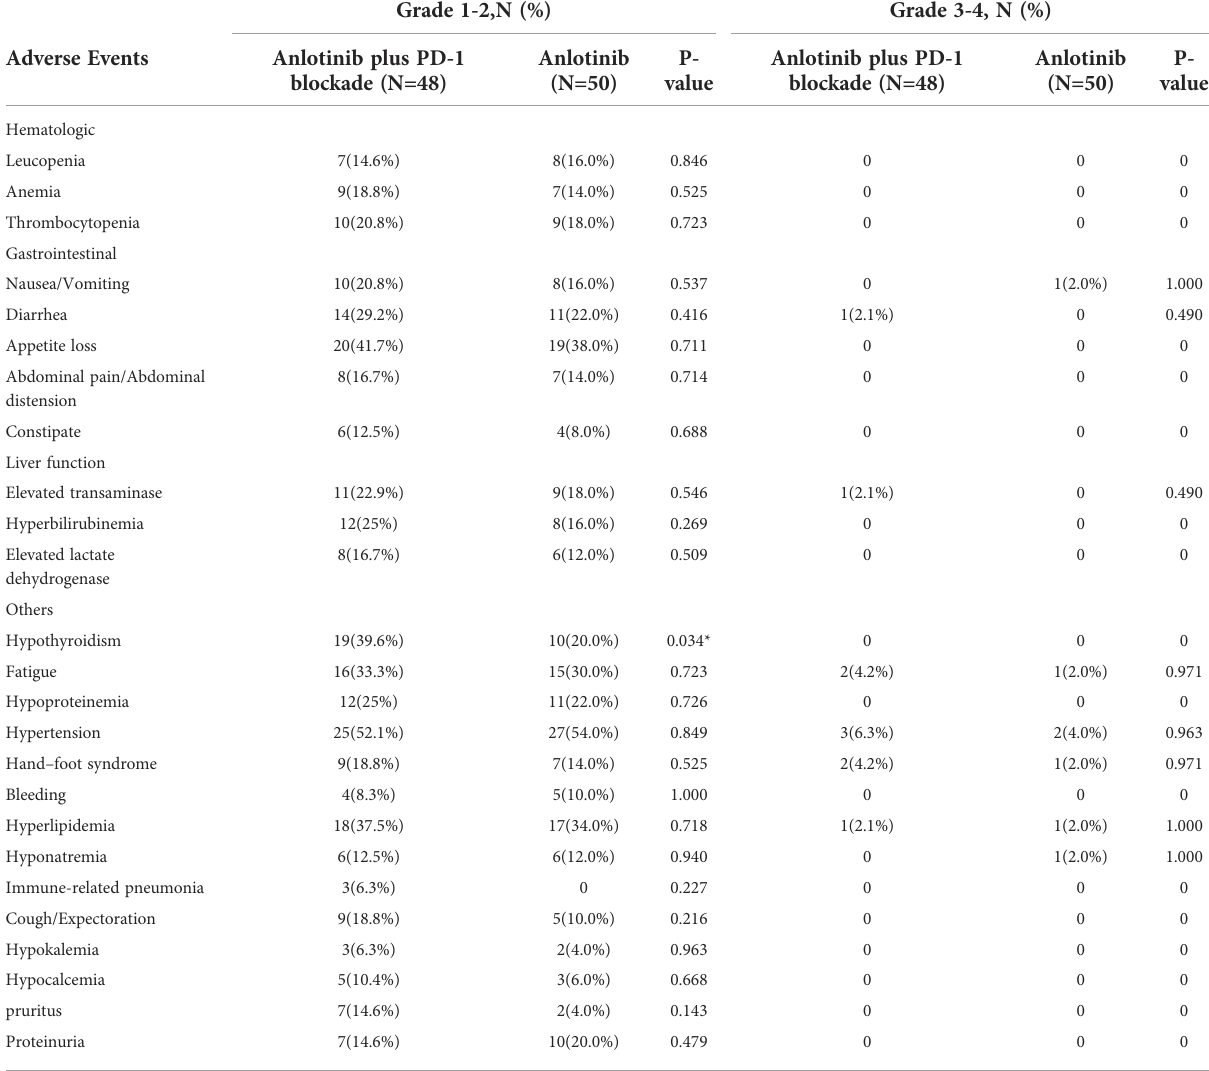
TABLE 5 Treatment-related adverse events in the two groups.